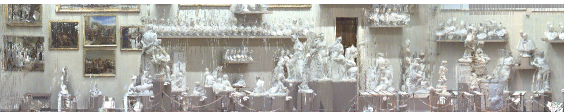
Figure 2. View of the bottom part of the room inside of the Gal- leria dell’Accademia di Firenze considered as case study in this work.